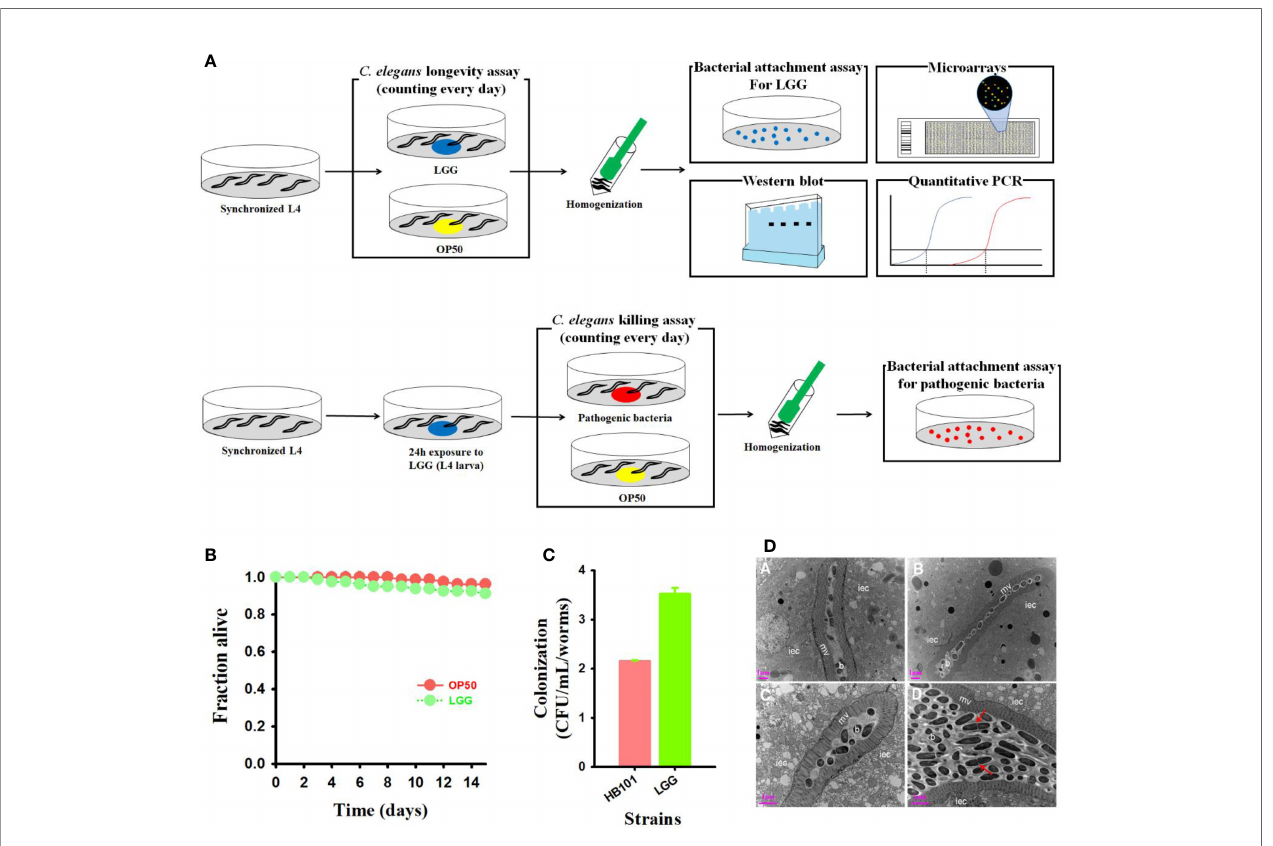
FIGURE 1 | Treatment of probiotics LGG to C. elegans and high adhesion in the intestine. (A) Schematic diagram of experimental design (Details are in materials and methods). (B) Monitoring the viability of C. elegans fer-15;fem-1 C. elegans (n=40 per well) exposed to LGG or OP50 (normal feed). (C) Bacterial counts (colony forming unit) in C. elegans intestine and (D) TEM images of transverse mid-body sections of C. elegans fed with OP50 (a, b) or LGG (c, d). Higher magni fi cation showing microvilli, intestinal epithelial cells, bacterial colonization in the intestinal lumen iec, intestinal epithelial cell; mv, microvilli; b, bacterial cells (OP50 or LGG). Scale bar = 1 m